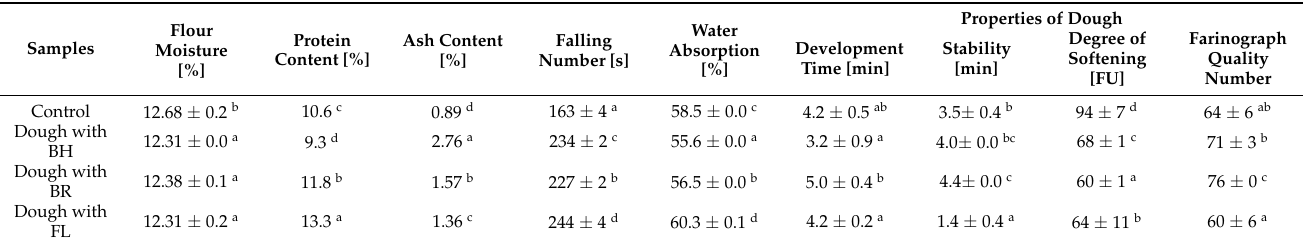
Table 2. Selected quality indicators of flour and dough